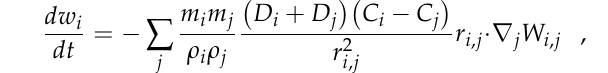
Table 2. Model parameter of the Fluid. SPH Parameter Fluid Value Number of SPH fluid particles 25,758 Mass of each particle m F,low viscosity 1.19 × 10 − 5 kg Mass of each particle m F,medium viscosity 1.21 × 10 − 5 kg Mass of each particle m F,high viscosity 1.22 × 10 − 5 kg Density (fluid) ρ F,low viscosity 1000 kg m − 3 Density (fluid) ρ F,medium viscosity 1017 kg m − 3 Density (fluid) ρ F,high viscosity 1020 kg m − 3 Dynamic viscosity (fluid) η L,low viscosity 1 mPa s Dynamic viscosity (fluid) η L,medium viscosity 13 mPa s Dynamic viscosity (fluid) η L,high viscosity 98 mPa